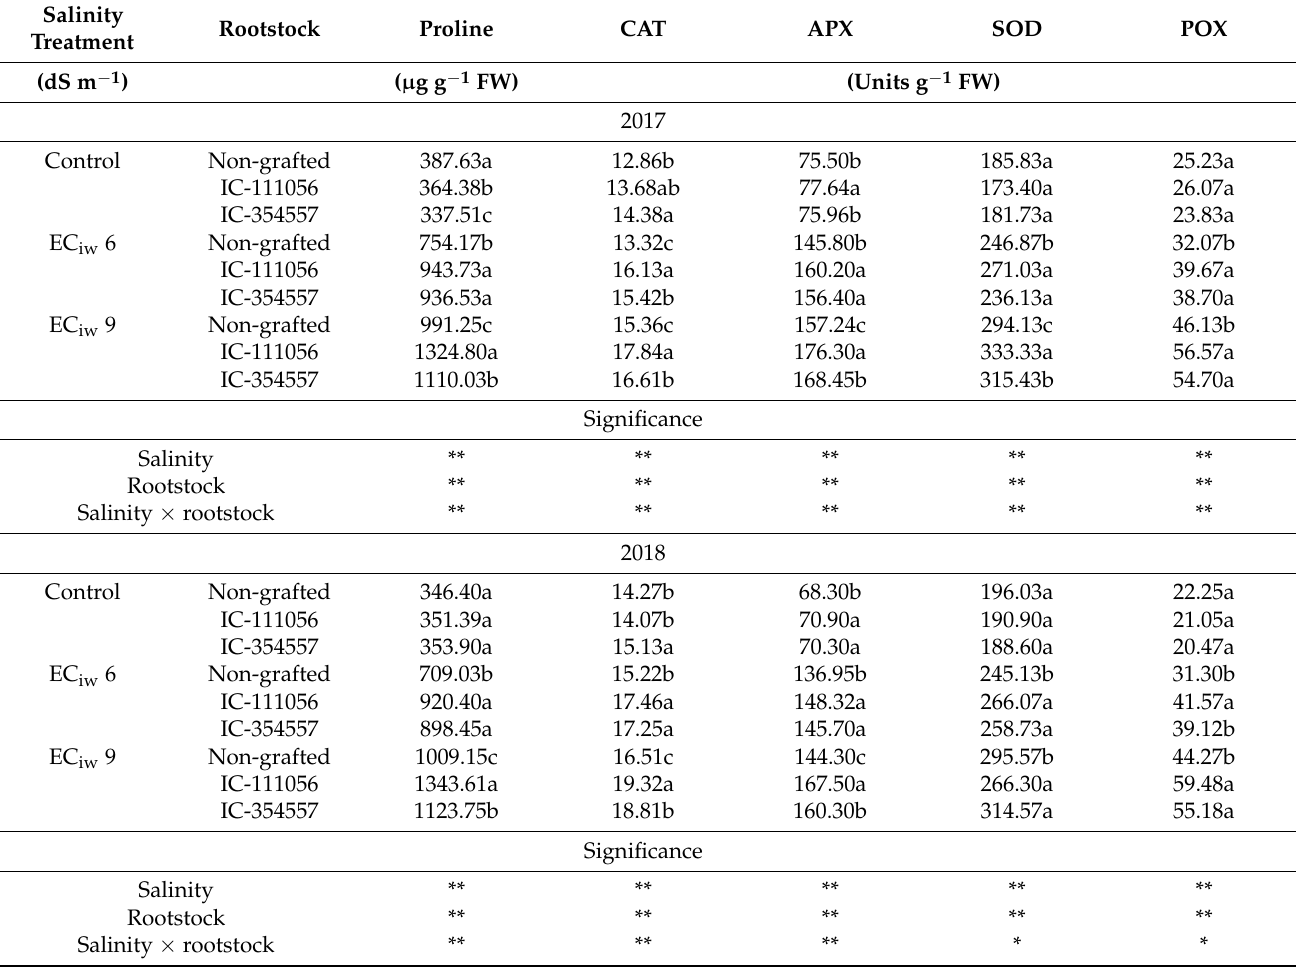
Table 3. Effect of salinity and rootstock combinations on biochemical parameters of tomato (cv. Kashi